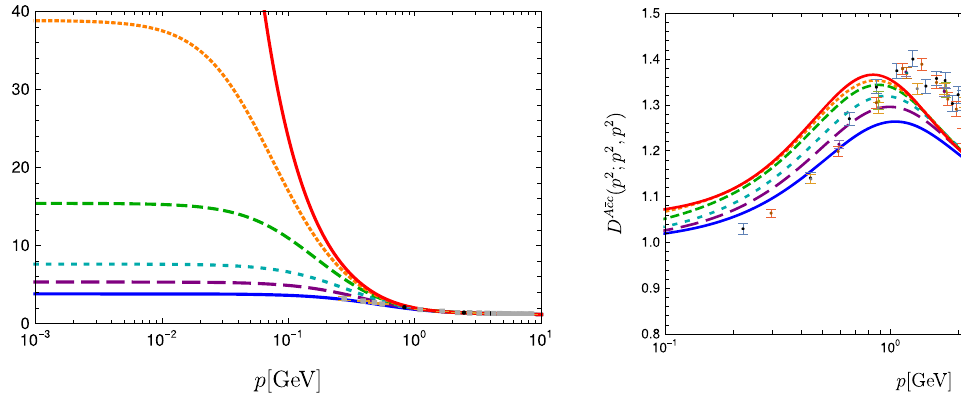
Fig. 4 Left: Ghost dressing function G ( p 2 ) in comparison to lattice data [52]. For the sake of comparison, the functional results were renormalized to agree with the lattice results at 8GeV. Right: Ghost-